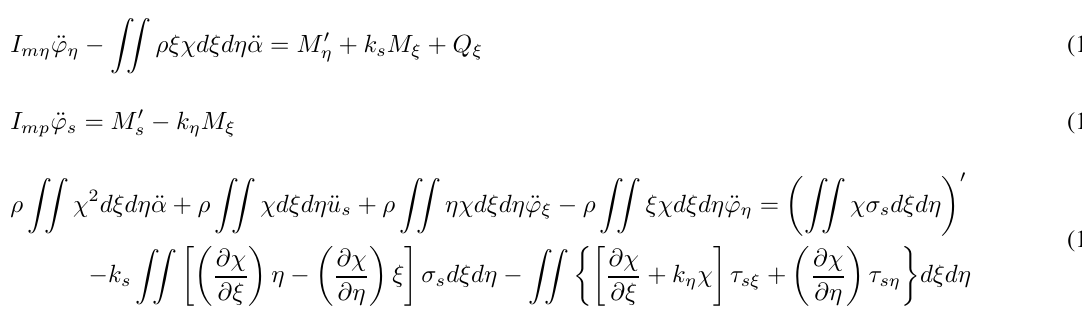
Fig. 2. The different types of helical springs with four cross-sectional shapes: (a) R max = R (b) R max = R 1 (c) R max = R 1 (d) R max = R 2